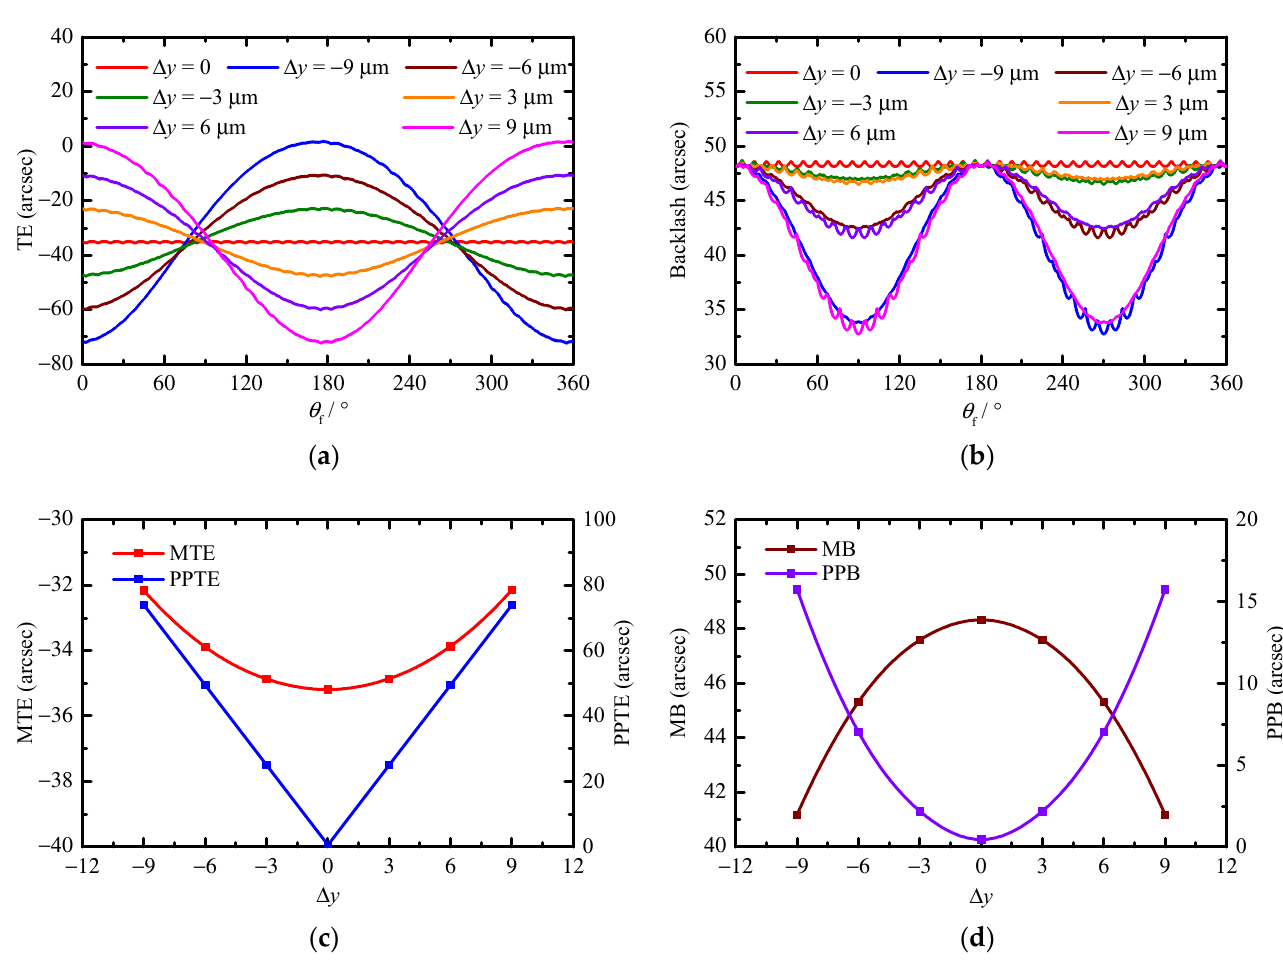
Figure 13. Results with center distance deviation: ( a ) TE, ( b ) backlash, ( c ) MTE and PPTE, and ( d ) MB and PPB.